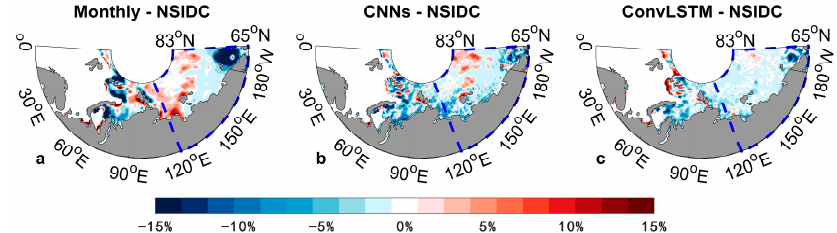
Figure 8. Comparison of the anomalies between different results, namely, monthly average ( a ), CNNs daily prediction ( b ), and ConvLSTM daily prediction ( c ) w.r.t the National Snow and Ice Data Centre (NSIDC) sea ice concentration (SIC) on 15 December 2018. The gray in the figure represents the land, and the blue/red represent the underestimation/overestimation of SIC. The area marked by the blue dotted line is the key contrast area in the following.